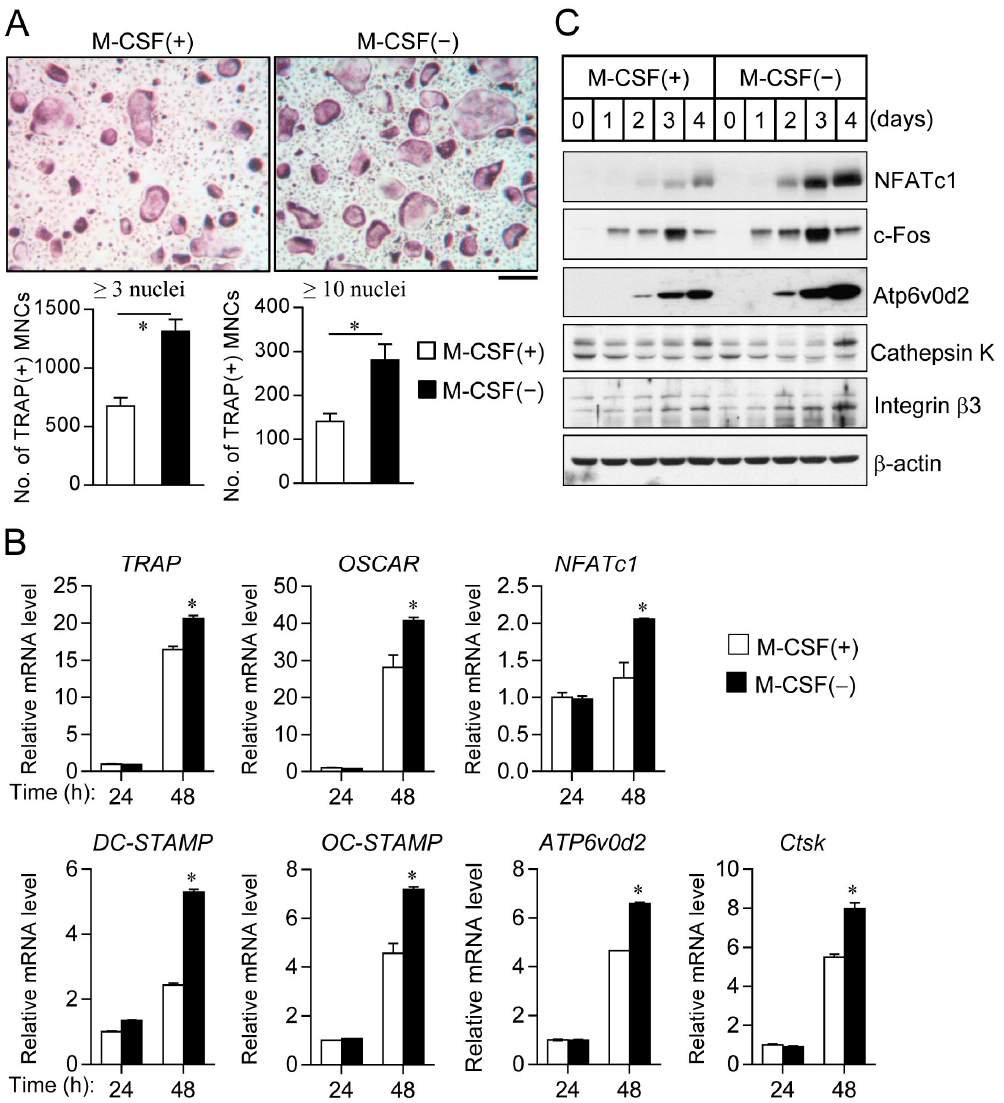
Figure 4. Prior M-CSF deprivation promotes osteoclast differentiation. ( A ) Osteoclast progenitors were cultured in the absence or presence of M-CSF for 12 h and were then exposed to M-CSF and receptor activator of nuclear factor- κ B ligand (RANKL) for 4 days to induce osteoclast differentiation. The cells were then stained for tartrate-resistant acid phosphatase (TRAP, upper panels ), and the number of TRAP(+) MNCs with ≥ 3 or ≥ 10 nuclei were counted ( lower panels ). Scale bar: 200 µ m; ( B ) Osteoclast precursors with or without M-CSF were differentiated into osteoclasts for the indicated times. The mRNA levels of osteoclastogenic marker genes, including TRAP, OSCAR, NFATc1, DC-STAMP, OC-STAMP, ATP6v0d2, and cathepsin K (Ctsk). Quantitative data are means ± SD; * p < 0.01 (Student’s t test); ( C ) Immunoblot analysis of osteoclast marker proteins for osteoclast progenitors cultured in the absence or presence M-CSF for 12 h and then exposed to M-CSF and RANKL for the indicated times.